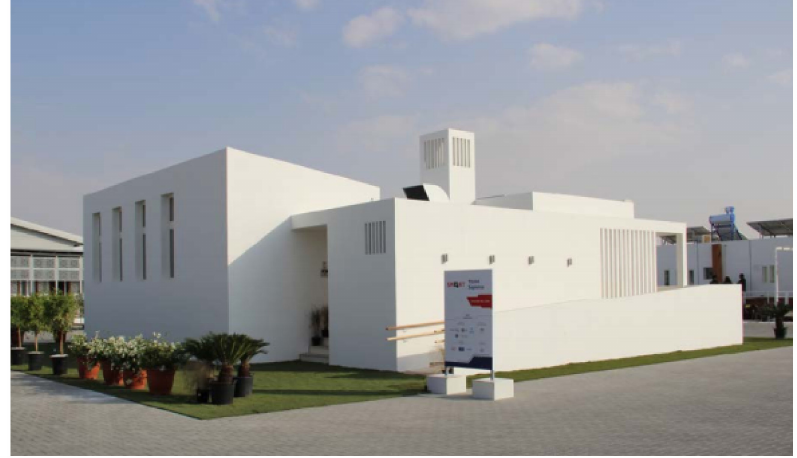
Figure 14. Sapienza house with semitransparent blinds and the wind tower. Reprinted from ref. [70].